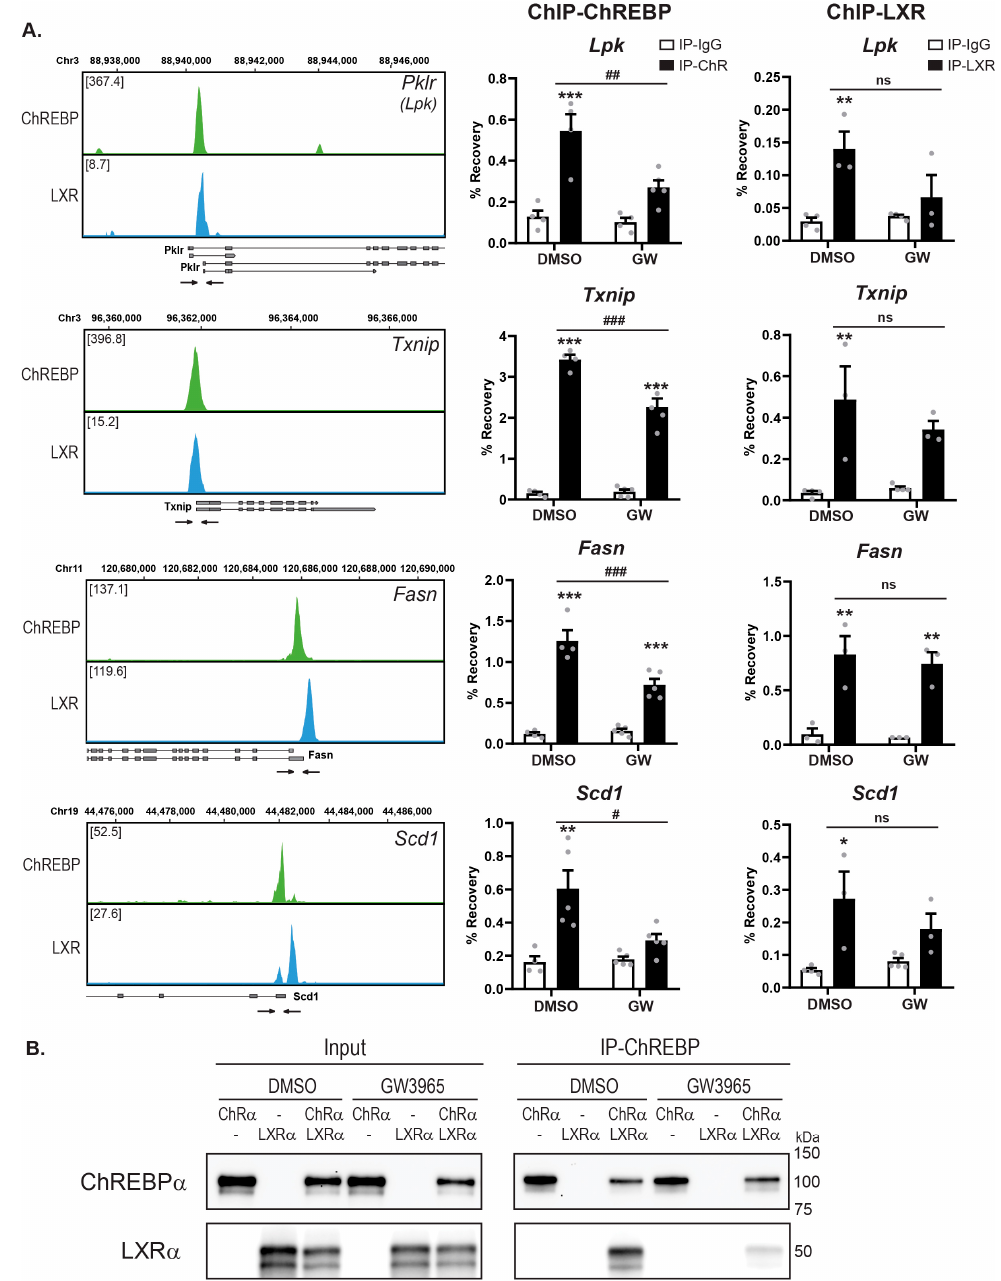
Figure 6. Ligand-activated LXR reduces ChREBP binding to chromatin. ( A ). Left panels: Local pattern of LXR-ChREBP co-occupancy. Browser view of LXR and ChREBP tracks in the promoter region of Lpk ( Pklr ), Txnip , Fasn and Scd1 . Square brackets indicate the scale maxima of ChIP / input ratios. Arrows indicate the genomic locations of quantitative RT-PCR primers. Right panel: AML12 cells transfected with ChREBP α / Mlx γ and LXR α / RXR α were treated with DMSO (0.1%) or GW3965 (10 μ M) for 18 hours. ChREBP or LXR binding to genomic location indicated in the right panels were detected by ChIP using antibodies against ChREBP, LXR or IgG as negative control. Data are presented as mean ± SEM ( n = 3–5). Significant differences are shown as * p < 0.05, ** p < 0.01, *** p < 0.001 compared to ChIP-IgG and # p < 0.05, ## p < 0.01, ### p < 0.001 between DMSO and GW3965 groups. ns, not significant. ( B ). CoIP of LXR α and ChREBP α , expressed in COS-1 cells cultured in 25 mM glucose, treated with DMSO (0.1%) or GW3965 (1 µ M) for 18 h. Lysates were immunoprecipitated with ChREBP antibody ( n = 3). Input and immunoprecipitated proteins were immunoblotted with ChREBP or LXR α antibodies. One representative western blot is